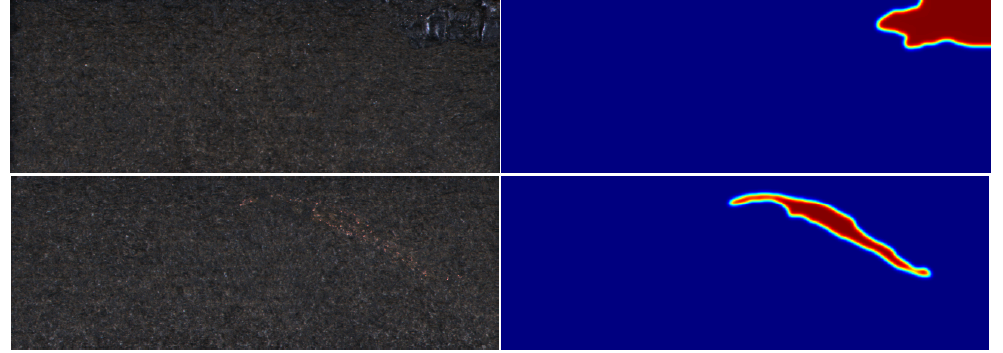
Figure 7. Mean IoU comparison of the balanced loss function and other loss functions on various networks trained on KolektorSDD2.